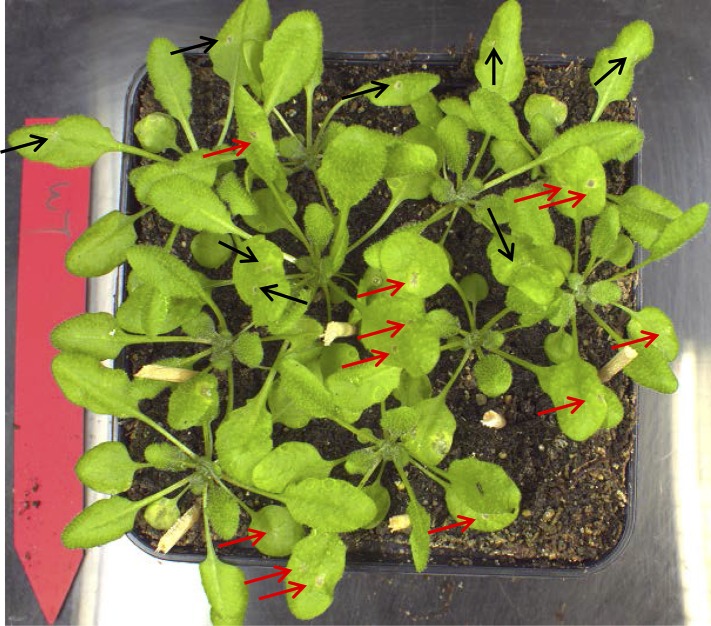
Phenotype of WT Col-0 plants treated with ABA.Infection droplets with ABA (10 μM; red arrows) or without ABA (black arrows) were applied to 4-week old leaves. No alteration of the WT resistant phenotype was observed. Picture was taken 3 days post inoculation of two 2 μl droplets containing 2.5 × 105 spores to each leaf.